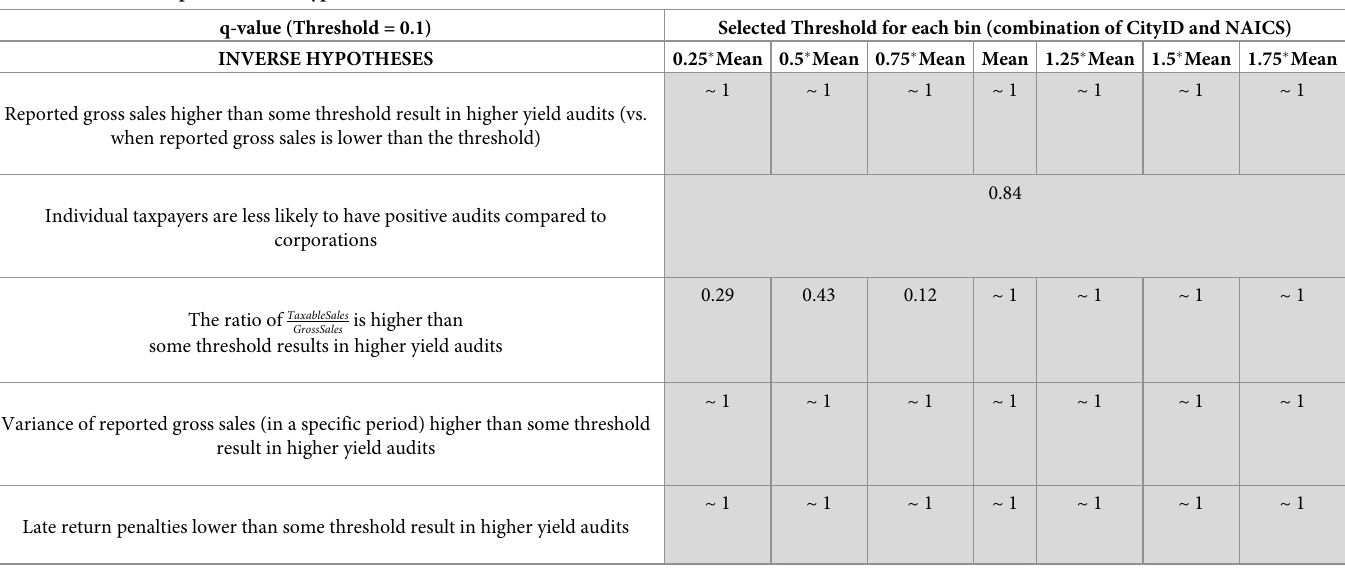
Table 2: Wilcoxon-ranksum test applied to the inverse hypotheses. A result less than 0.1 signifies a statistically significant result. Grayed-out cells mark non-significant results. “~ 1” results denote probabilities arbitrarily close to